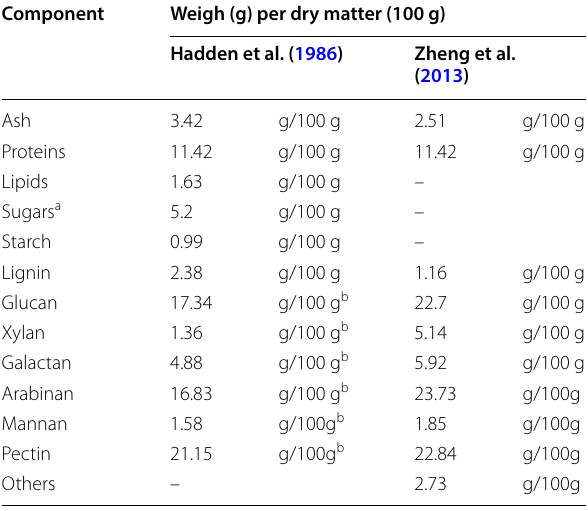
a Total value of rest of fructose, glucose, sucrose and fructan b Conversion of values to polysaccharides in the paper